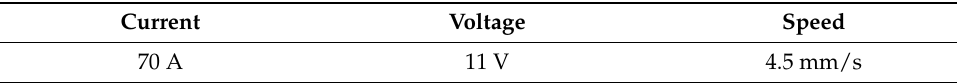
Table 3. Optimum weld parameters for vent panel.